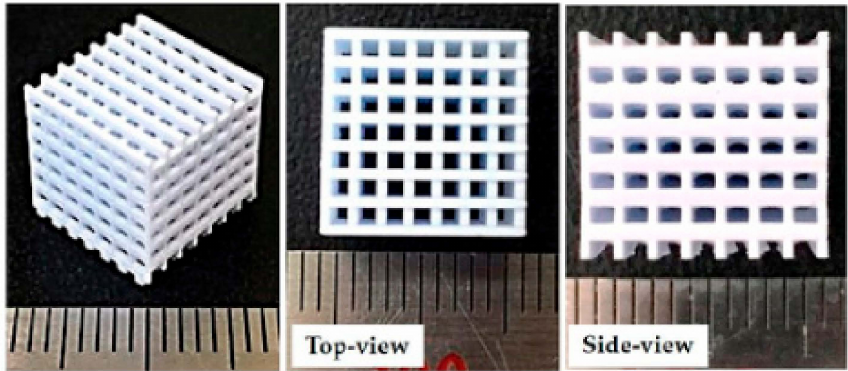
Figure 6. CaP scaffold with porous structure